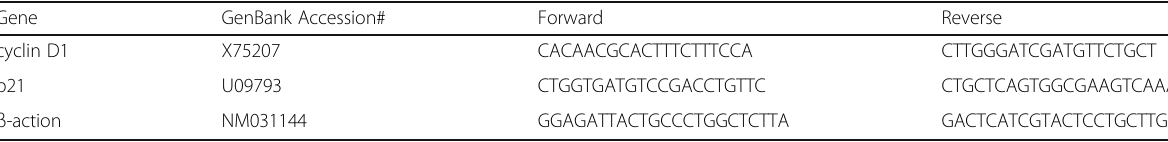
Table 1 Primer sequences for gene expression by real-time PCR Gene GenBank Accession# Forward Reverse cyclin D1 X75207 CACAACGCACTTTCTTTCCA CTTGGGATCGATGTTCTGCT p21 U09793 CTGGTGATGTCCGACCTGTTC β -action